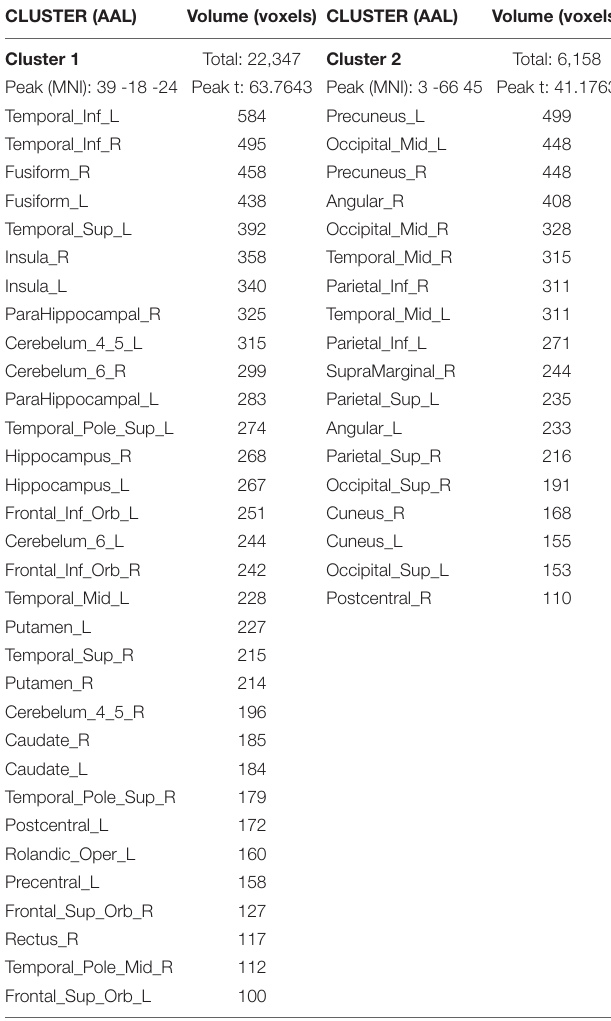
TABLE 2 | ANOVA revealed differences among three